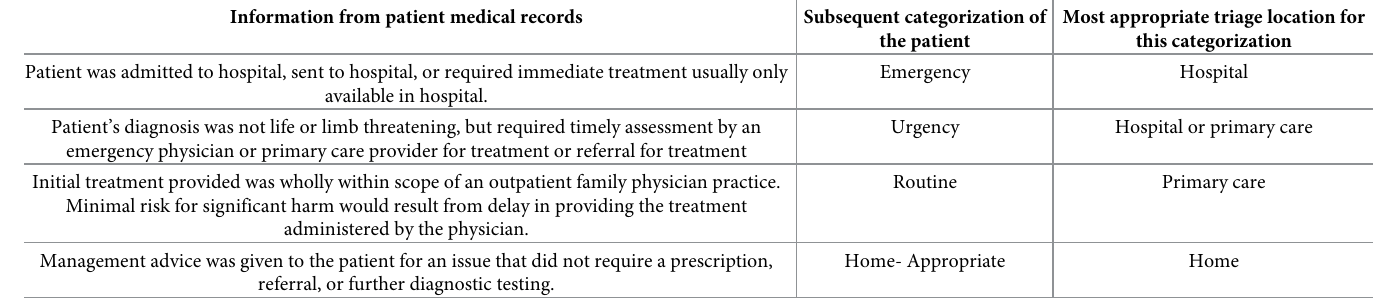
Table 1. Criteria used for categorizing the acuity of patient medical encounters with a healthcare professional. Information from patient medical